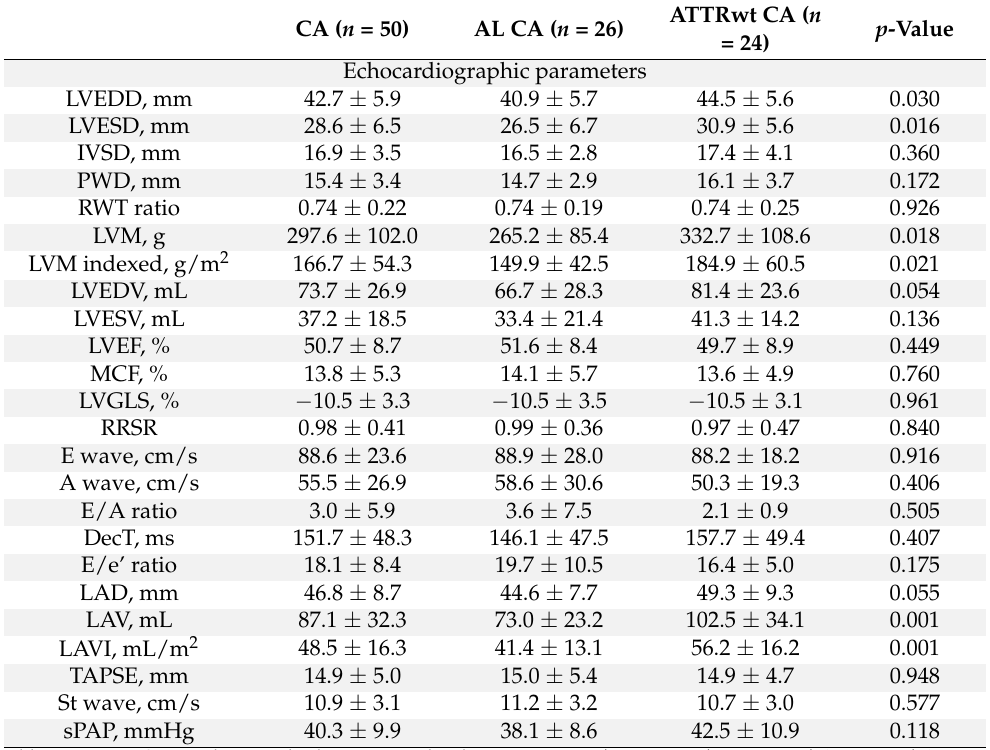
Table 2. Echocardiographic parameters of the study